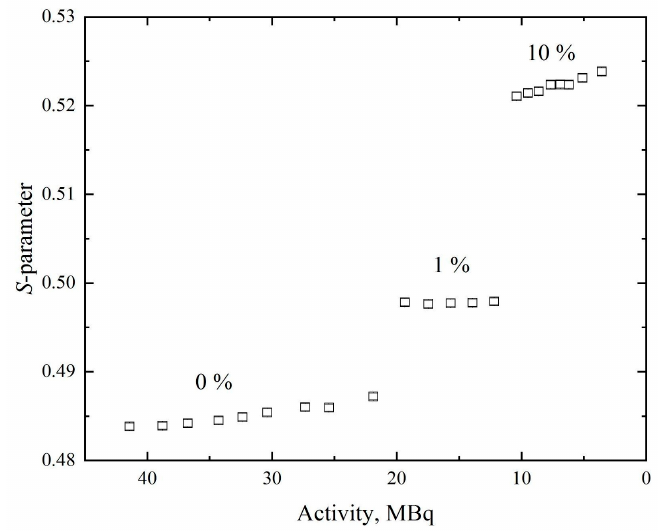
Figure 9. Dependence of S -parameter on activity for Ti samples with different dislocations density.